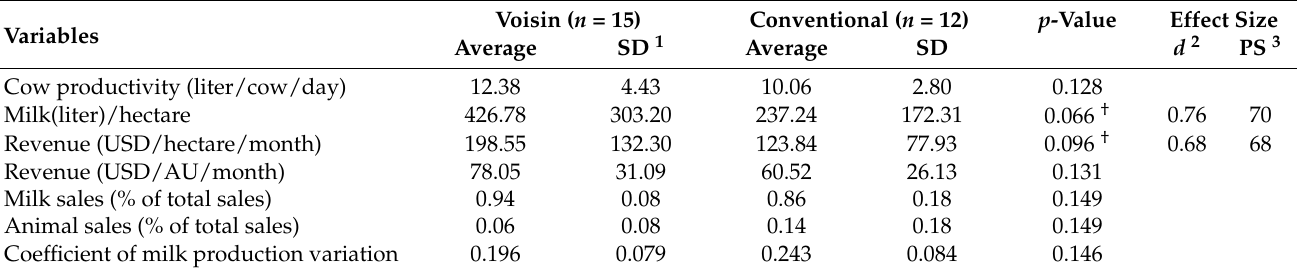
Table 7. Cow and land productivity, revenue per hectare and animal unit (AU), percentage of revenue from milk and animal sales on total sales, and coefficient of milk production